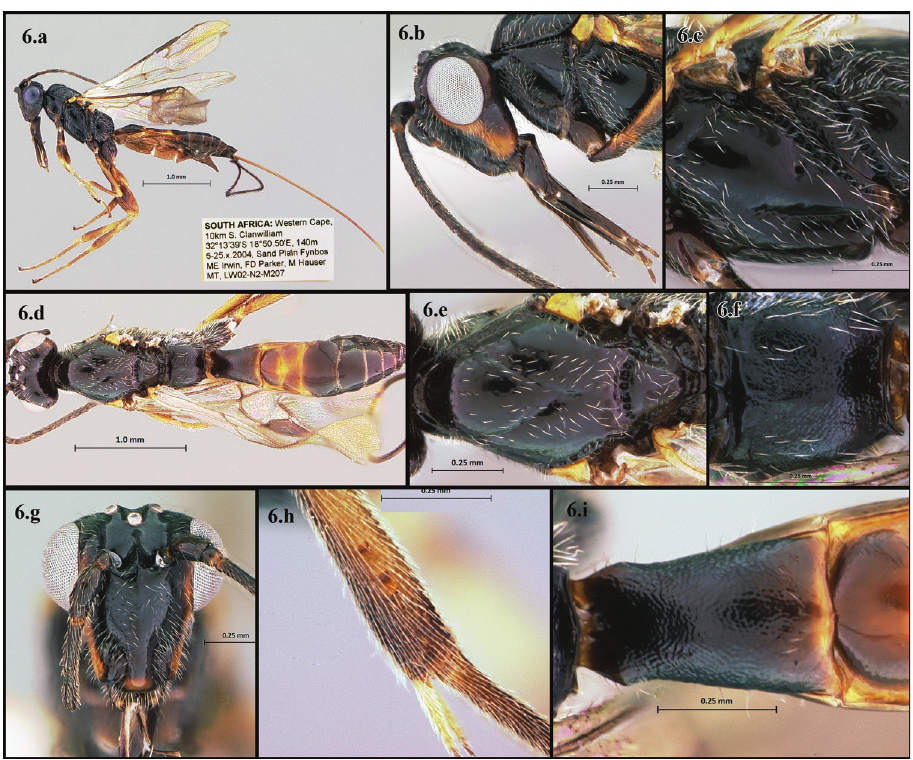
Figure 6. Camptothlipsis inertusursus a lateral habitus b lateral head c mesopleuron d dorsal habitus e dorsal thorax f propodeum g anterior head h mid tibial spines i first median tergite of